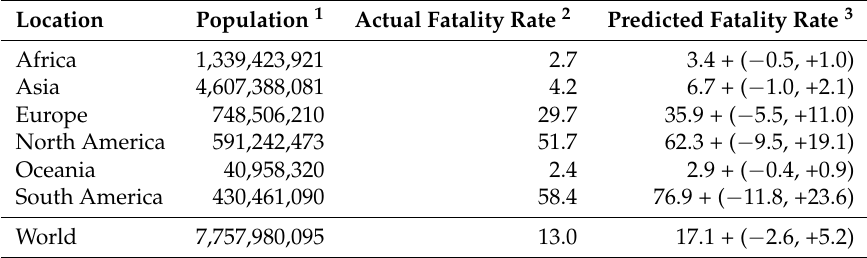
Table 4. Actual and predicted fatality rates (deaths per 100,000